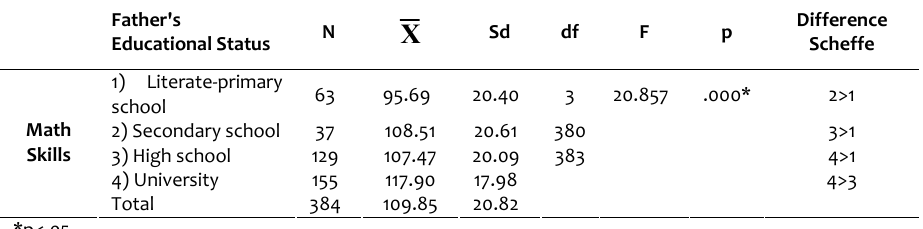
Table 11. Results of ANOVA on Math Skills of the 5-Year-Old Preschoolers According to Father's Educational Status